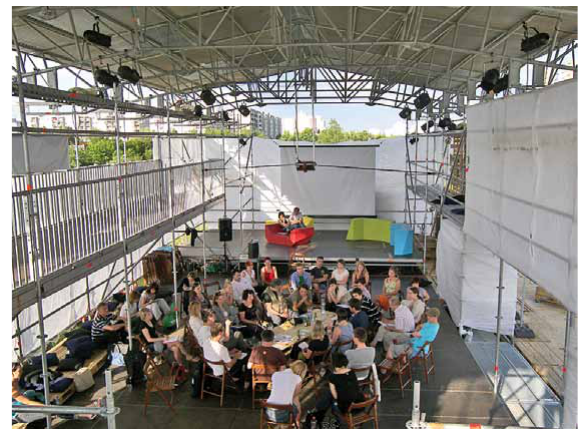
fig. 10. “Zone Ideal”, Prague 2012. P. Kratochvíl